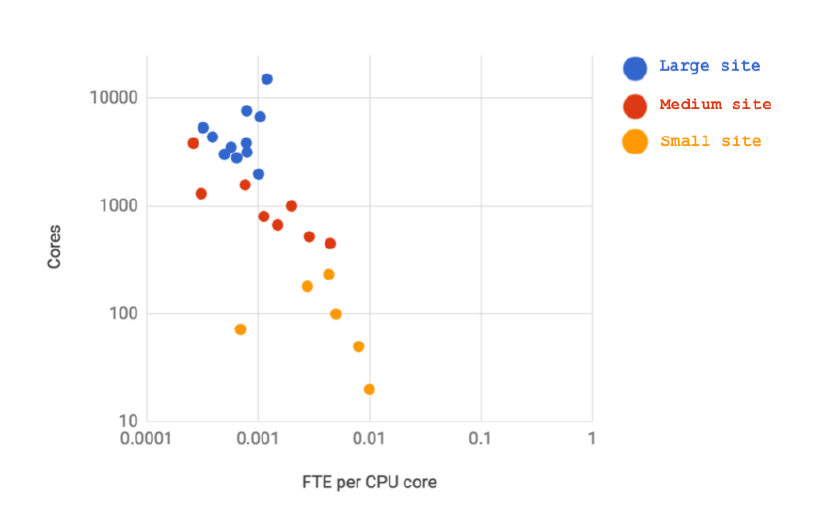
Figure 2. FTE needed per core.